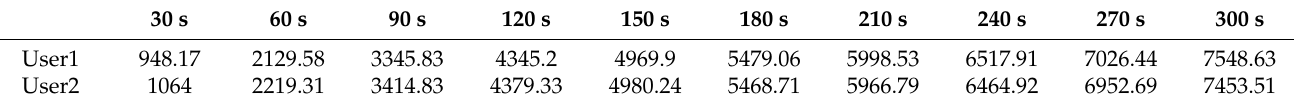
Figure 11. The quantum key consumption of the user. Table 3. The quantum key consumption in different time